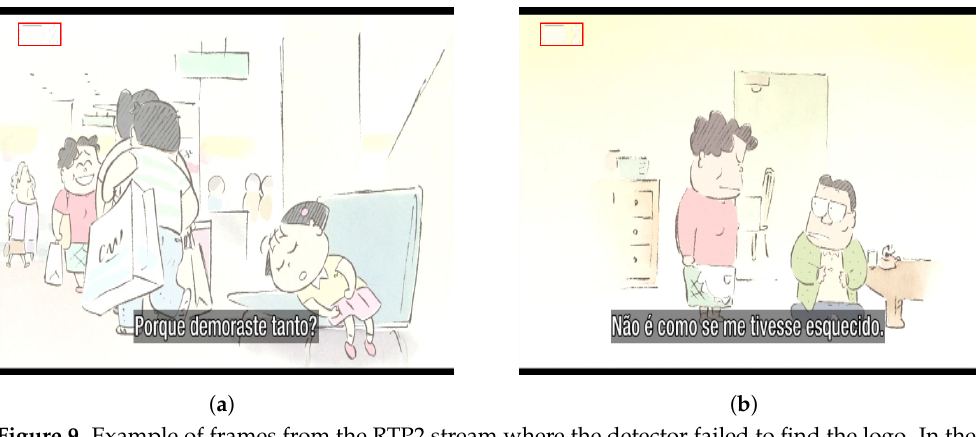
Figure 9. Example of frames from the RTP2 stream where the detector failed to find the logo. In the left frame ( a ) the logo is imperceptible, even for humans. The frame on the right ( b ), show the logo just slightly perceptible.